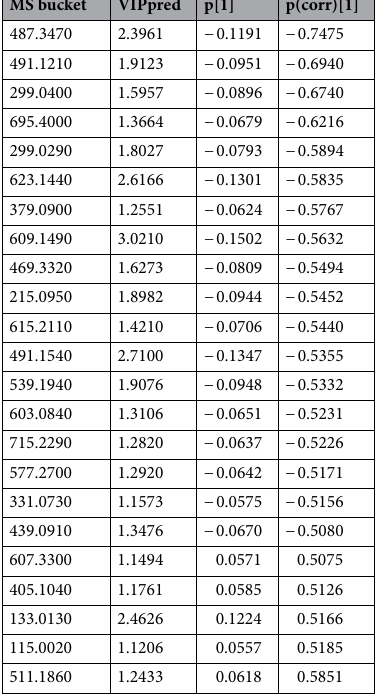
Table 3. Selected MS variables related to metabolites with the highest potential as biomarkers (VIP predictive > 1.0 and |p(corr)|> 0.5). MS data derives from the analysis of olive leaf samples.